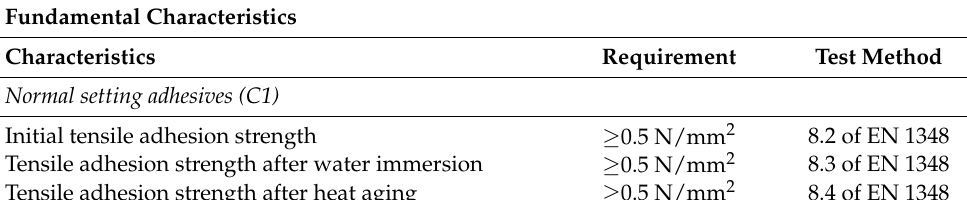
Table 1. Requirements for cementitious (C) adhesives for ceramic tiles (CTA) according to EN 12004:2007+A1:2012